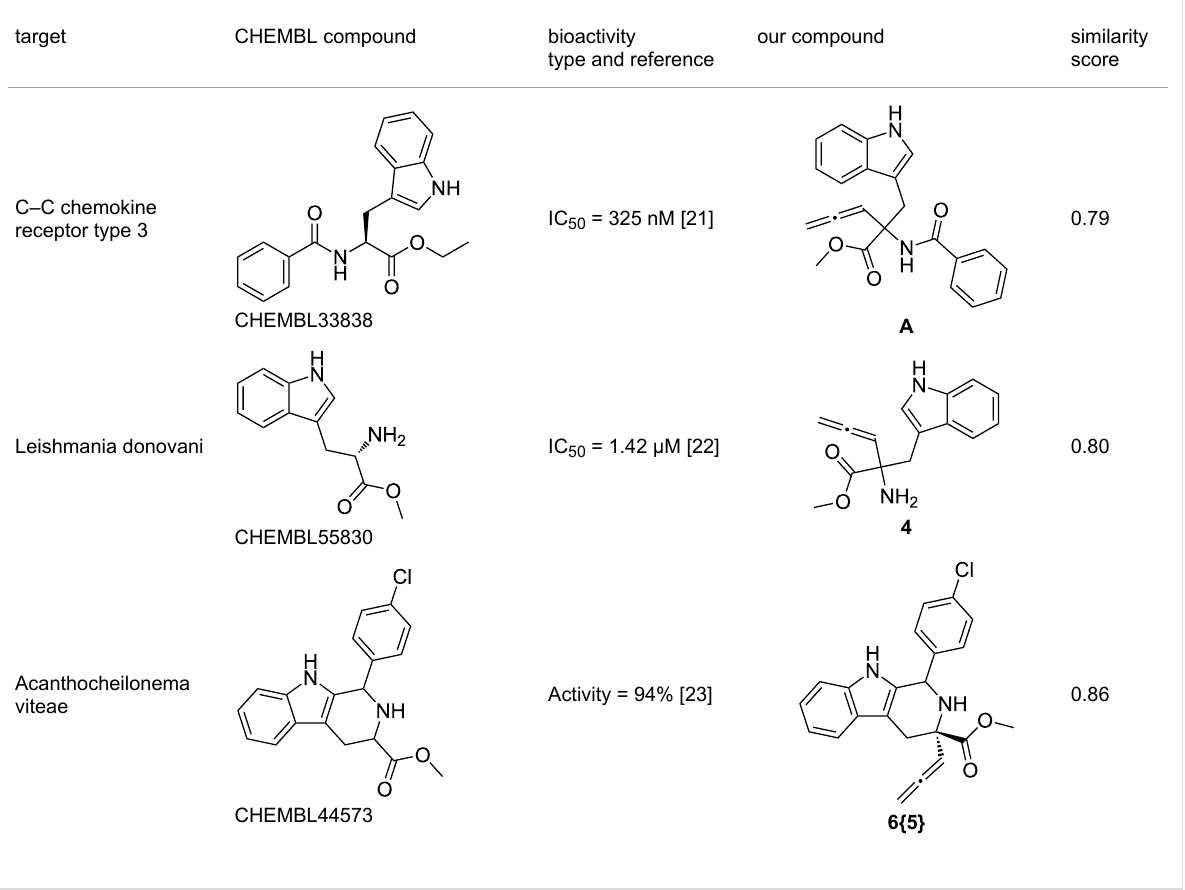
Table 4: Potential targets of β -carbolines based upon bioactivity data in ChEMBL.